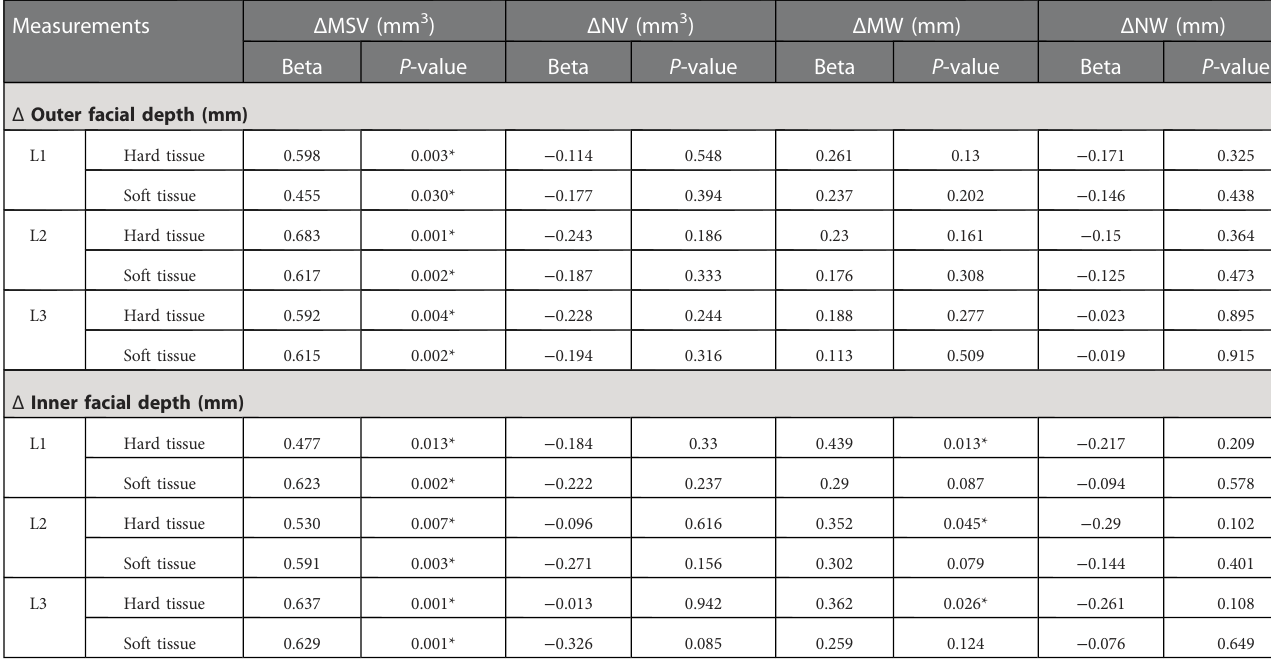
TABLE 3 Multiple linear regression analysis for facial depth change.